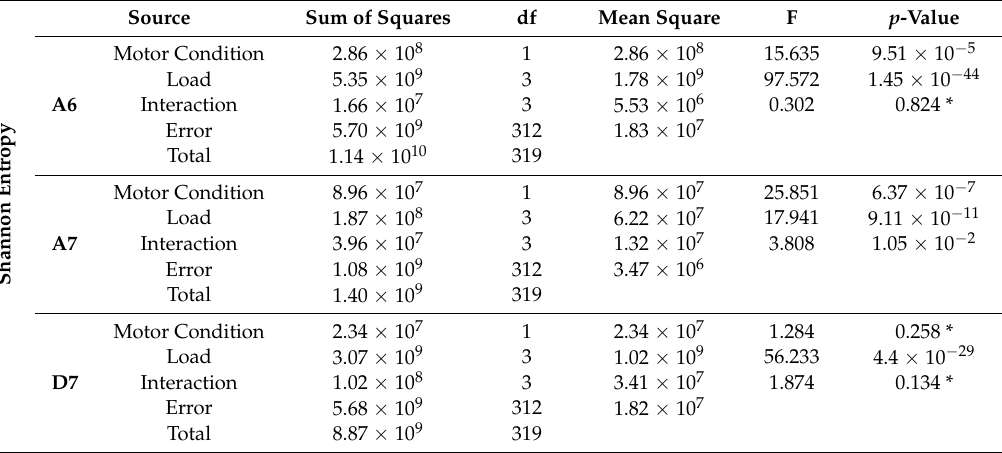
Table 3. Analysis of variance for Shannon entropy features.